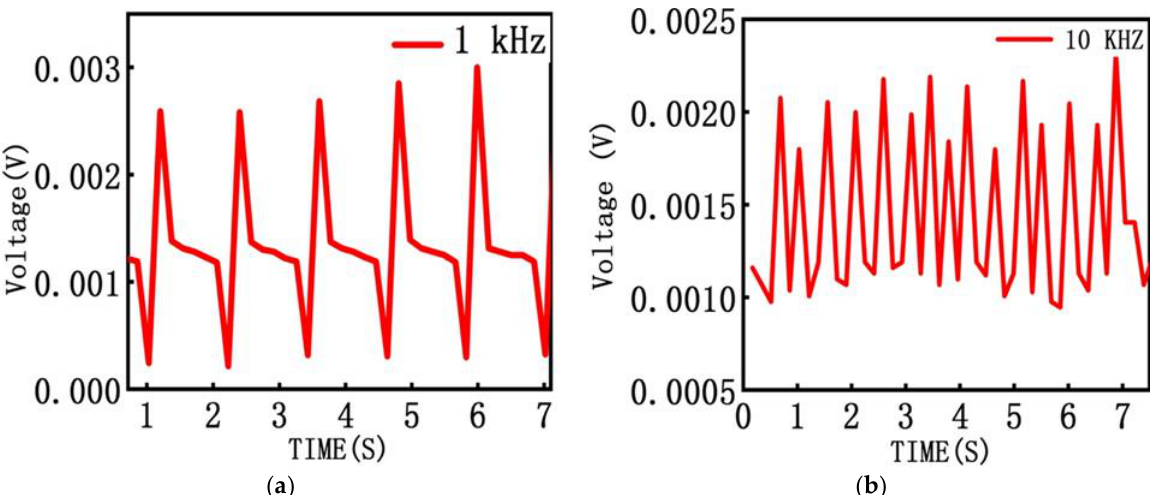
Figure 3. Rapid response of the output voltage of the piezoresistive tactile sensor under different loading pressures at frequencies of ( a ) 1 kHz and ( b ) 10 kHz.